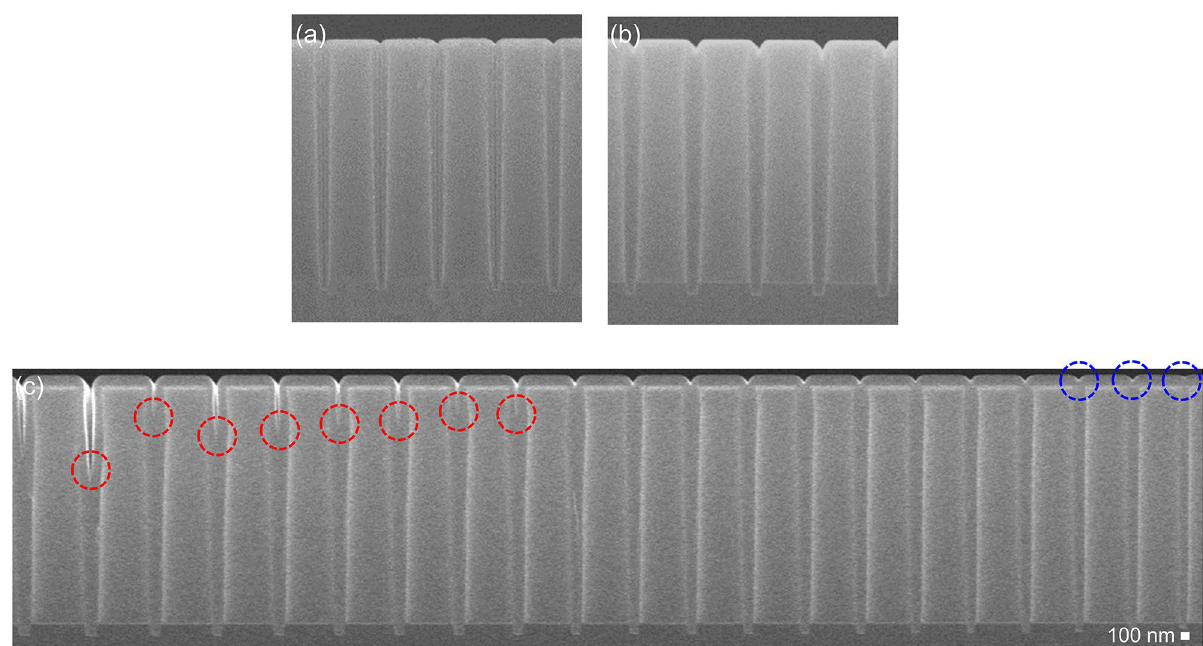
Figure 11. Cross-sectional FE-SEM images of the trench pattern (opening and depth of 200 nm and 2.5 μm, respectively) after conducting SiO 2 PE-ALD with ( a ) no inhibitor and ( b ) NH 3 * , followed by wet etching (diluted HF of 200:1 for 60 s). ( c ) Cross-sectional FE-SEM images after conducting SiO 2 PE-ALD with NH 3* on the trench pattern with a depth of 3 μm and an opening size varying from 300 (left) to 100 (right)